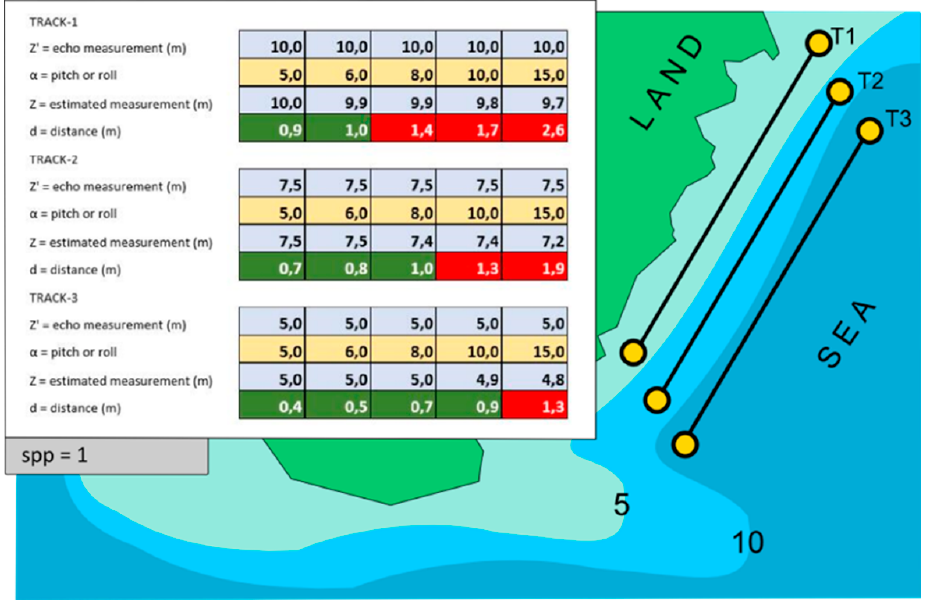
Figure 7. Example of three data acquisitions with spp = 1 constant and with α and Z ′ variables. Table 2. Variation of the distance d with the changing depth (see also Figure 7).